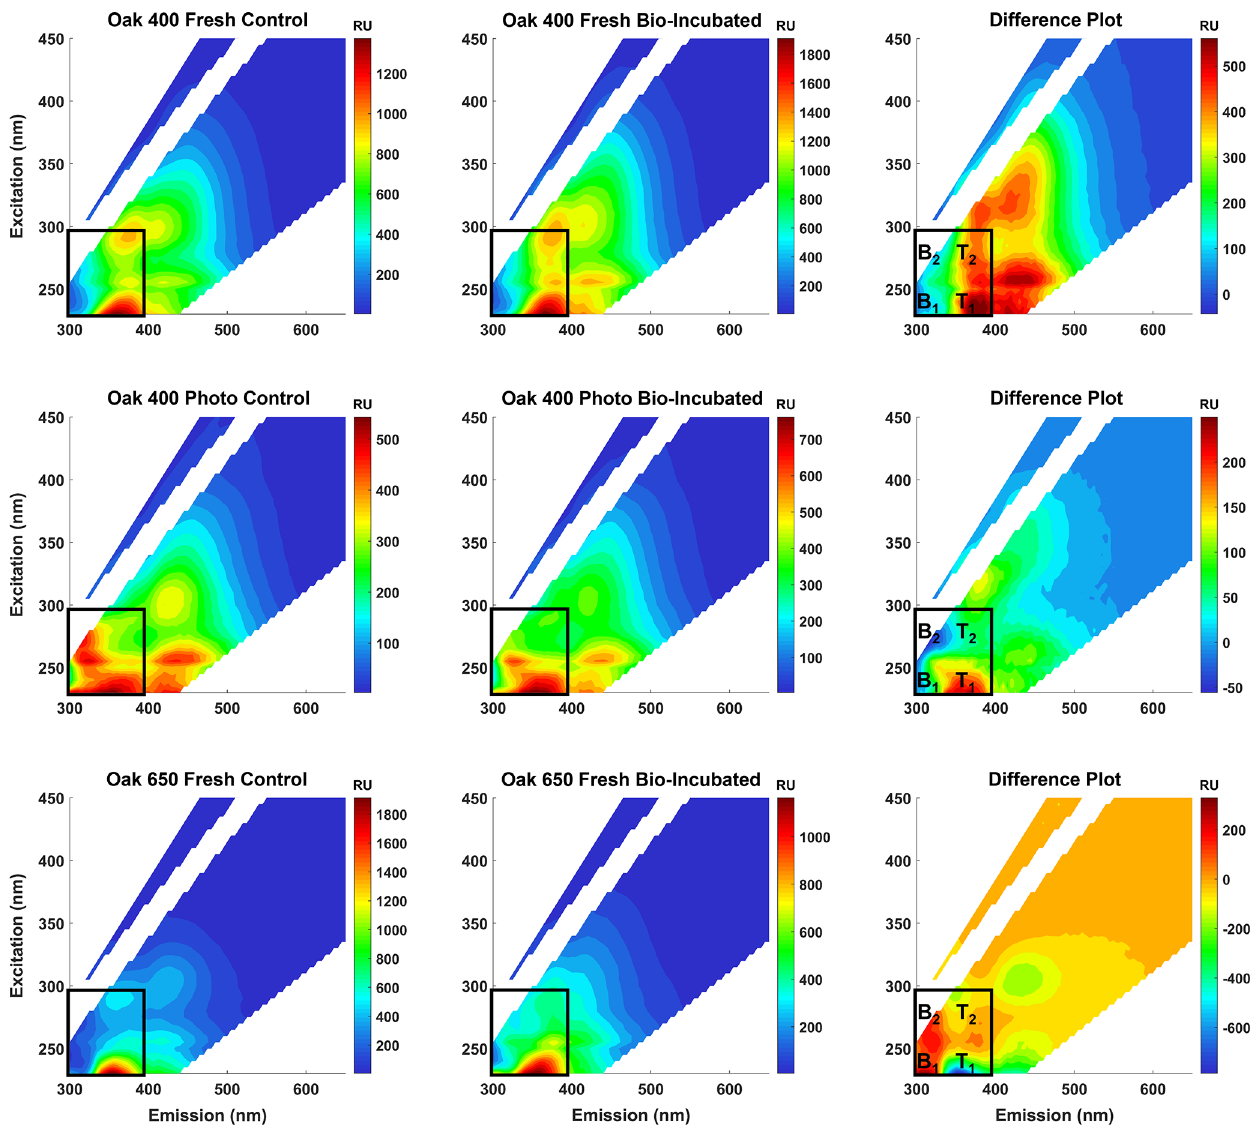
Figure 2. Fluorescence excitation–emission matrices (EEMs) of control (left panels) and bio-incubated (middle panels) pyDOM samples. Difference spectra are shown in the right panels. The black box indicates the region where compounds of proteinaceous origin fluoresce (Coble, 1996; Coble et al., 2014), with tyrosine-like ( B 1 and B 2 ) and tryptophan-like ( T 1 and T 2 ) peaks labeled on the difference